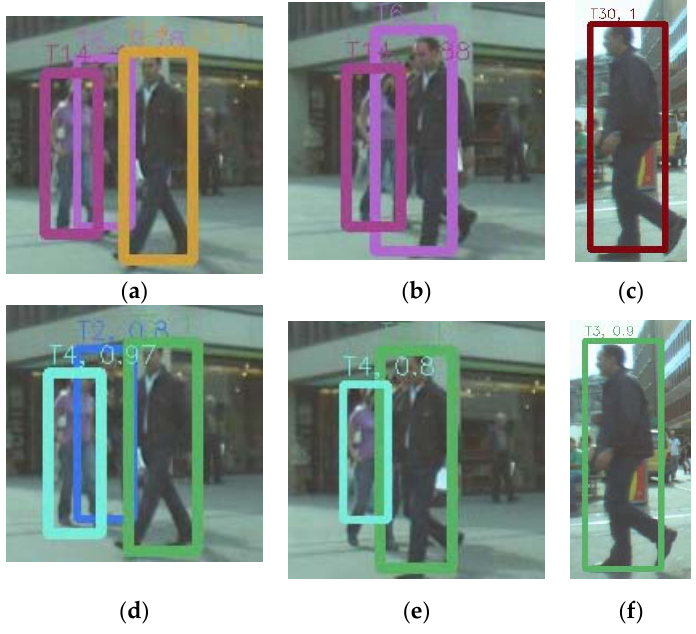
Figure 5. A qualitative comparison between the proposed method and the reversible jump Markov chain Monte Carlo (RJMCMC) algorithm with the ETH ‐ Linthescher video. In this figure, ( a – c ) show the results obtained by the RJMCMC method in frames No. 32, 34, and 54; ( d – f ) respectively show the correspondent results with the proposed method.